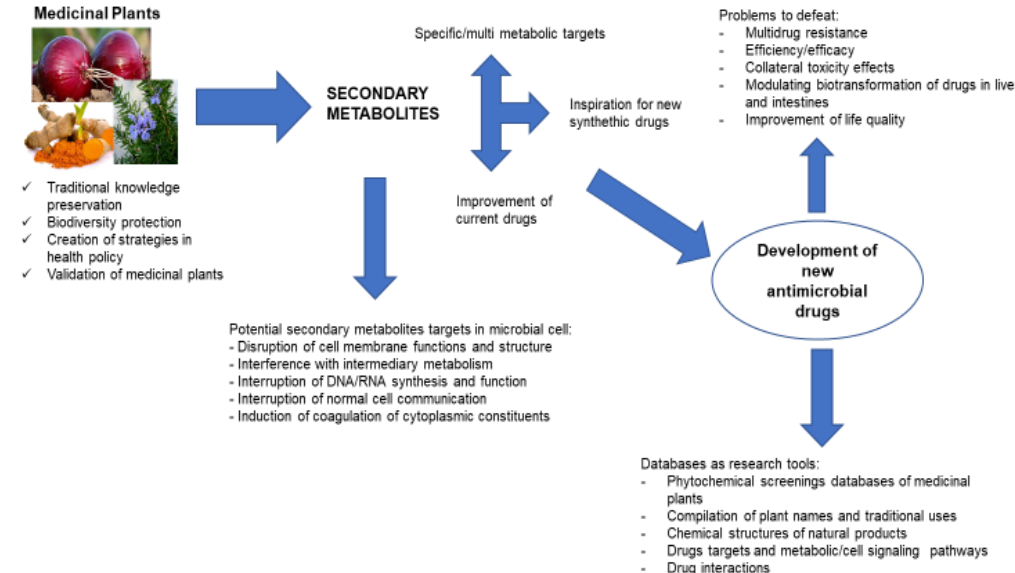
Figure 1. Flow diagram summarizing the potential of natural products in the discovery of new antimicrobial agents.